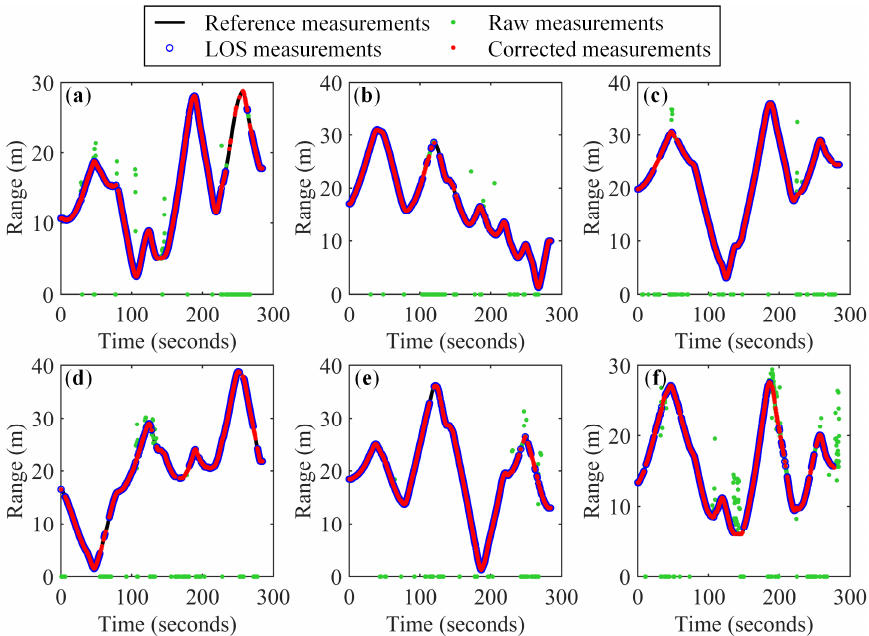
Figure 7. Time series of the reference measurements (black), UWB raw measurements (green), LOS measurements (blue) and corrected measurements (red) for different anchors: ( a ) anchor 1, ( b ) anchor 2, ( c ) anchor 3, ( d ) anchor 4, ( e ) anchor 5, and ( f ) anchor 6.